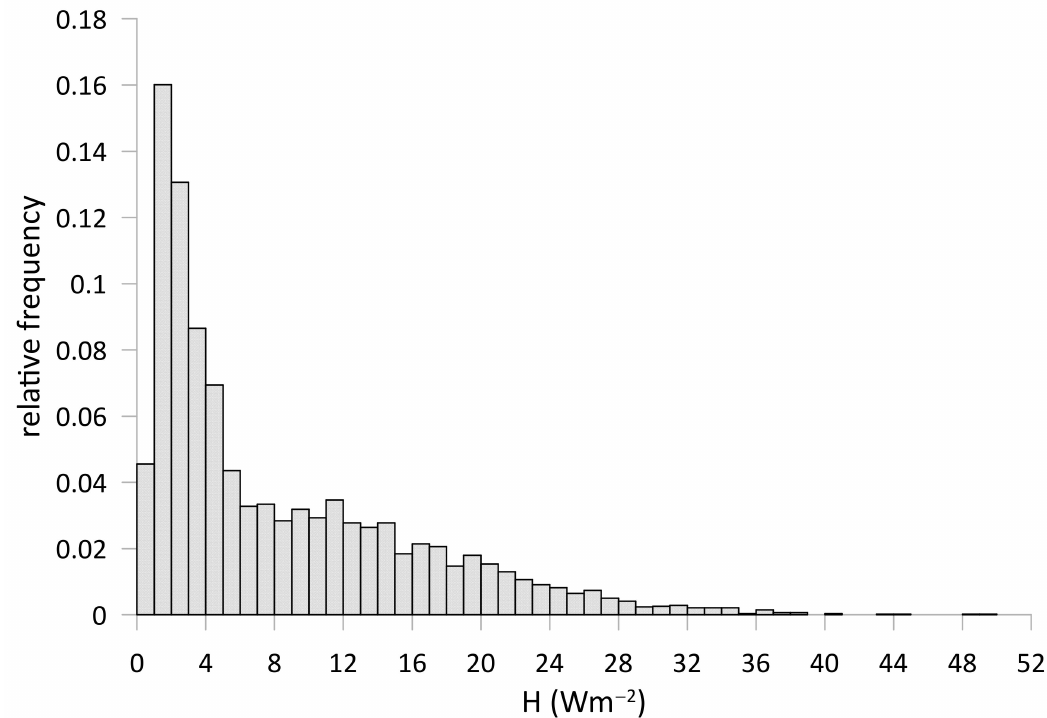
Figure A1. Relative frequency distribution of the absolute random errors at an hourly scale for the sensible heat